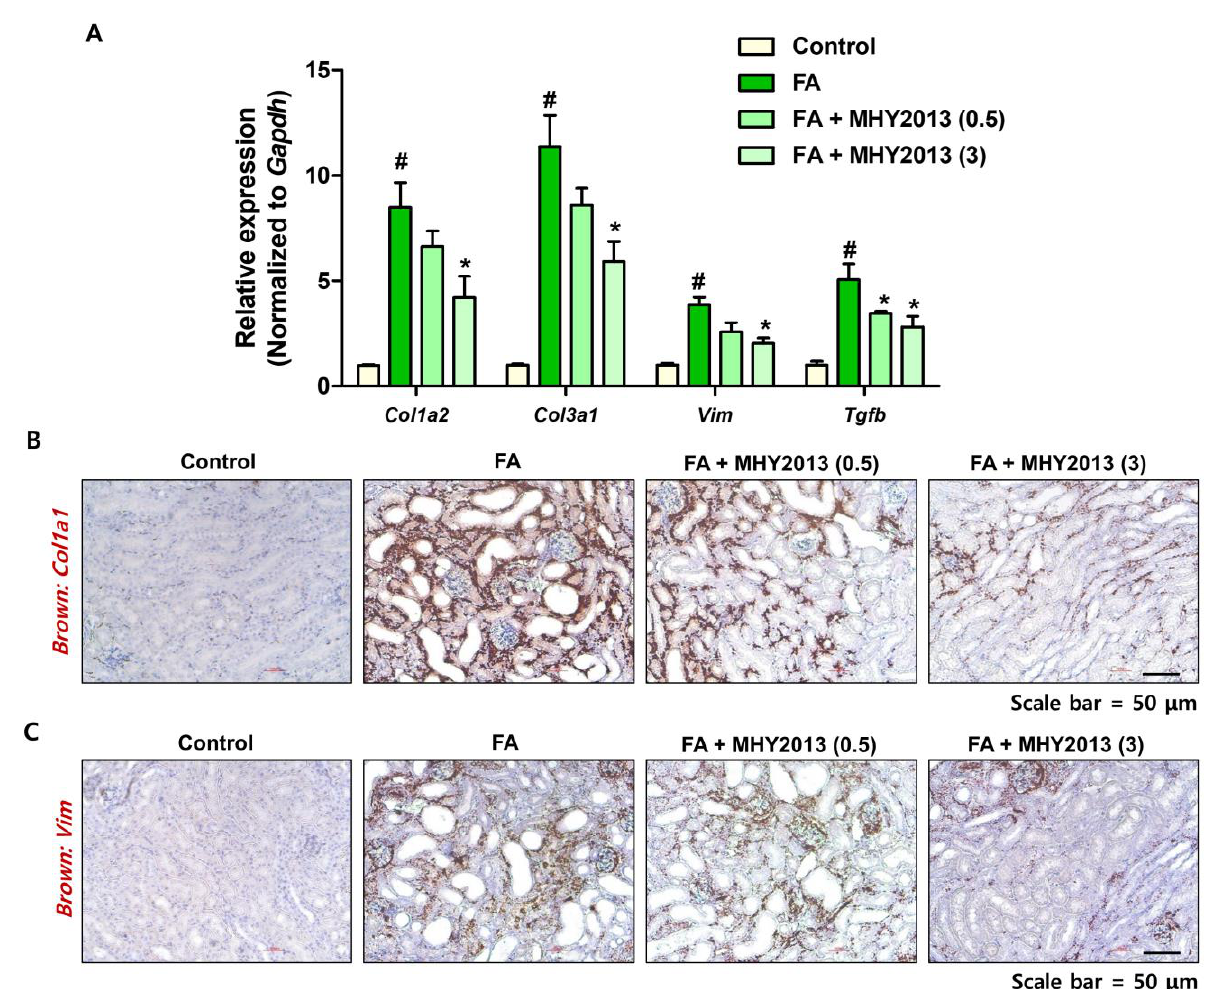
Figure 2. MHY2013 treatment reduces fibrosis-related gene expression in FA model. ( A ) Relative gene expression levels of kidney fibrosis-related proteins ( Col1a2 , Col3a1 , Vim , and Tgfb ) in FA-treated kidneys with or without MHY2013 treatment. # p < 0.05 vs. control groups. * p < 0.05 vs. FA group. ( B ) Representative in situ hybridization images detected with Col1a1 (brown) probe in FA-treated kidneys with or without MHY2013 treatment. ( C ) Representative in situ hybridization images detected with Vim (brown) probe in FA-treated kidneys with or without MHY2013 treatment.